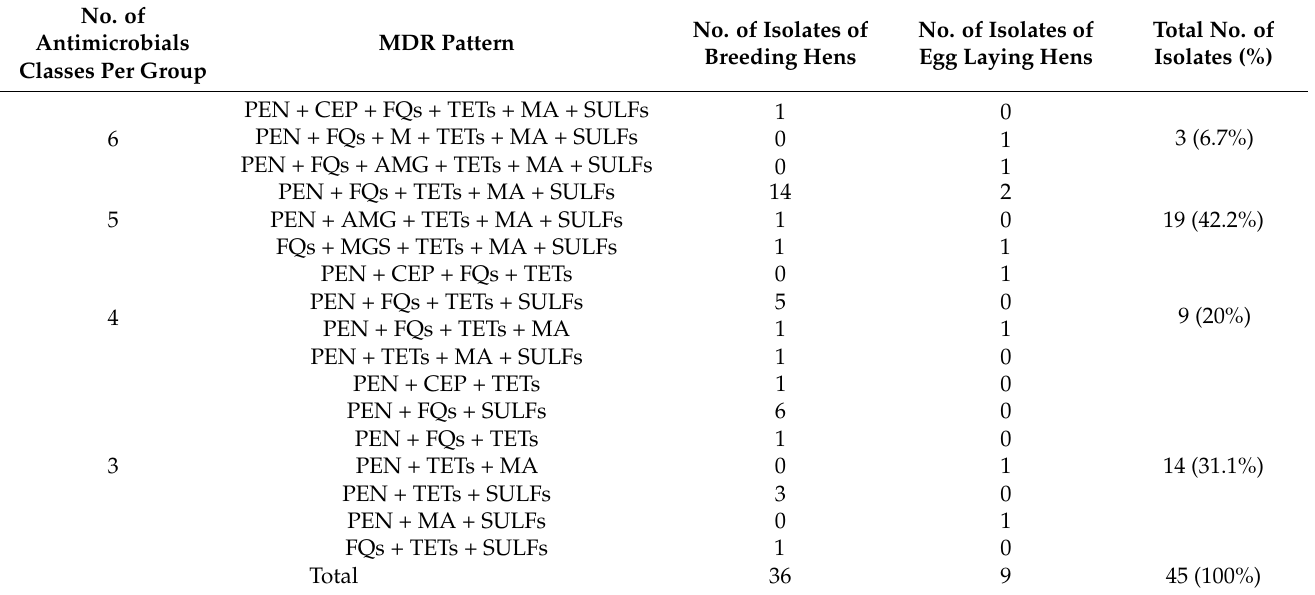
Table 5. Distribution of multi resistant isolates of E. coli and number of categories for which they exhibited resistance.